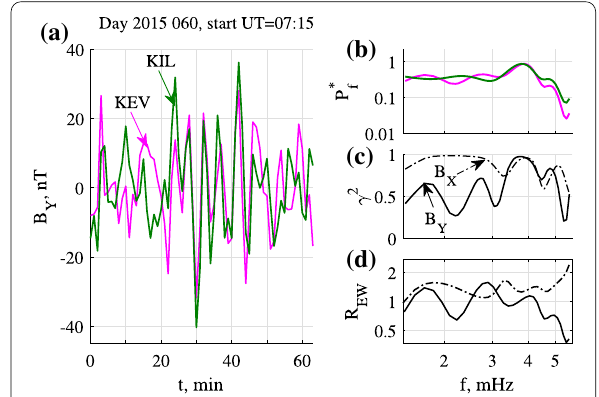
Fig. 2 Event 1 Pulsations recorded in the geomagnetic field and GIC on day 2015 060. a aveforms of B Y pulsations at KEV (magenta) and GIC at VKH (dark blue); b normalized PSD spectra; c B − I spectral coherence for B Y (solid line) and B X - (dashed); d GIC to B Y PSD ratio